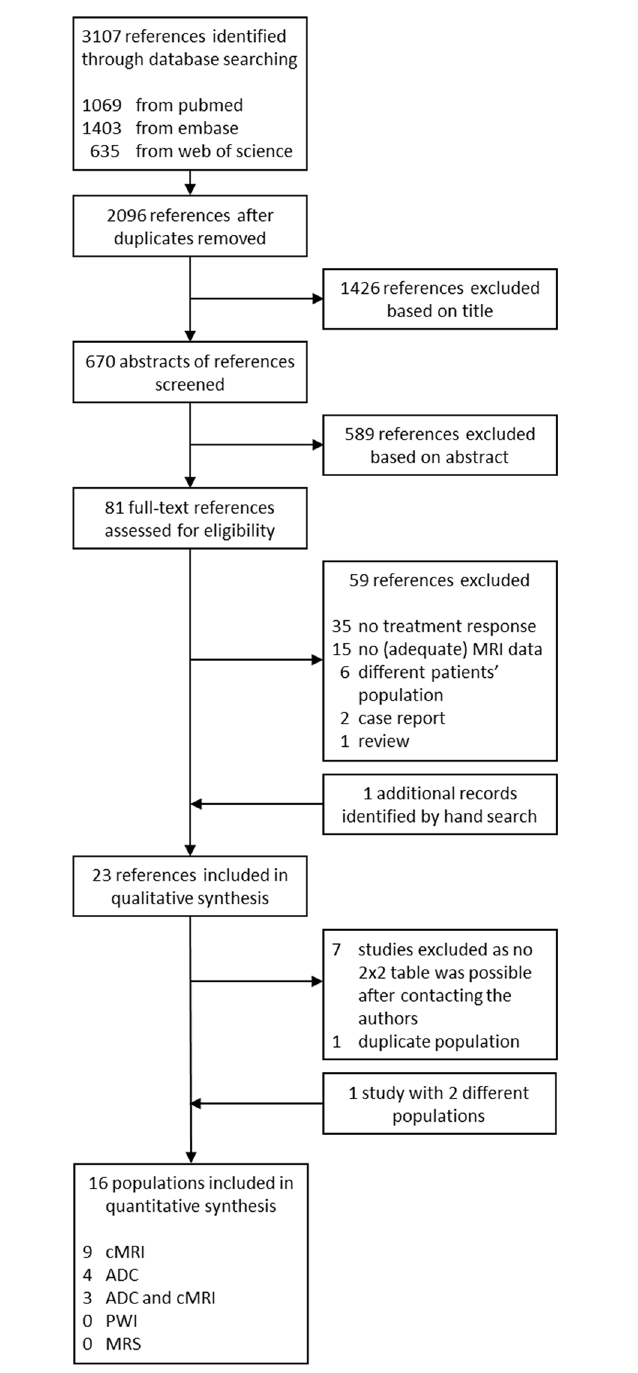
Fig 1. Flow chart literature